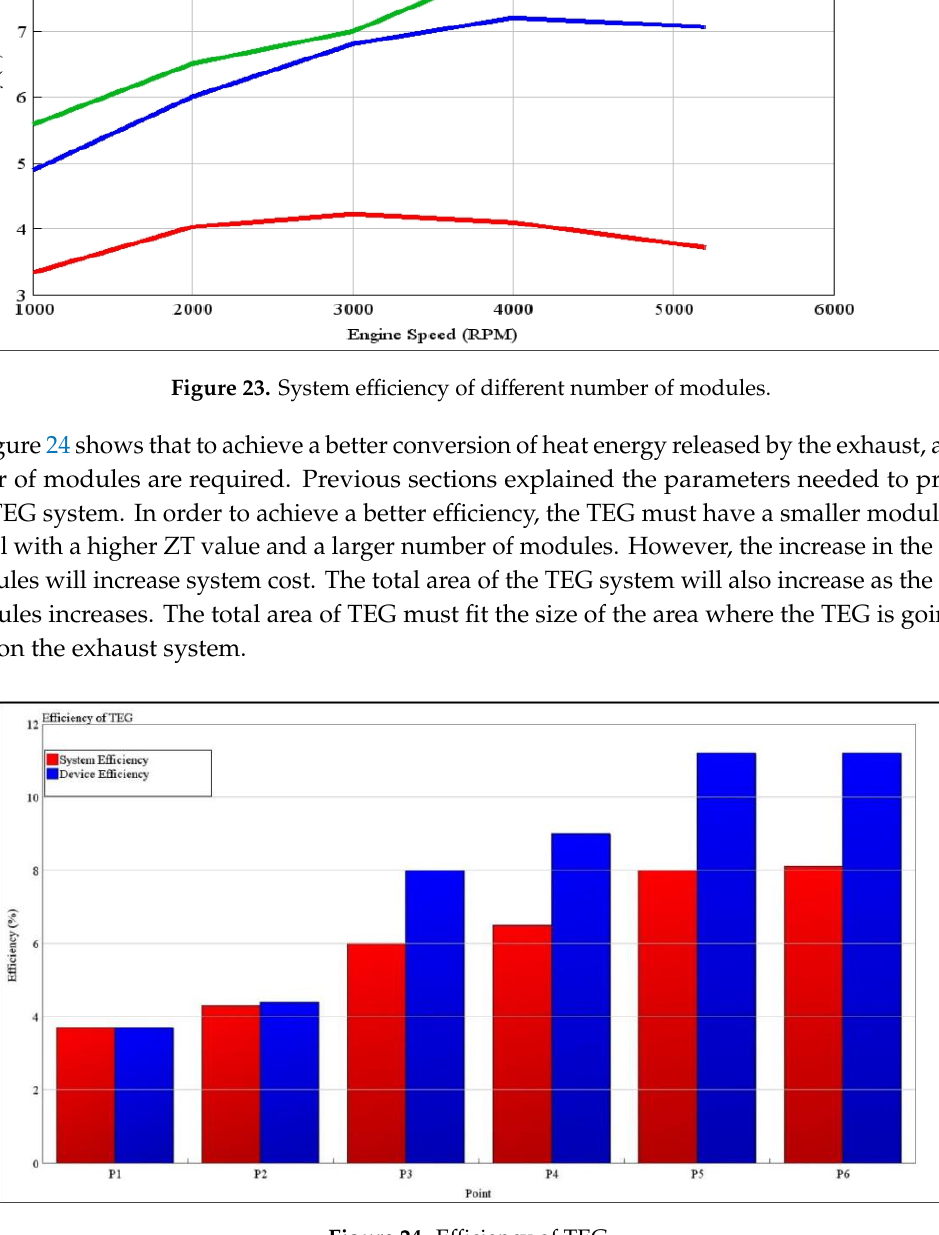
Figure 24. Efficiency of TEG. Figure 24. E ffi ciency of